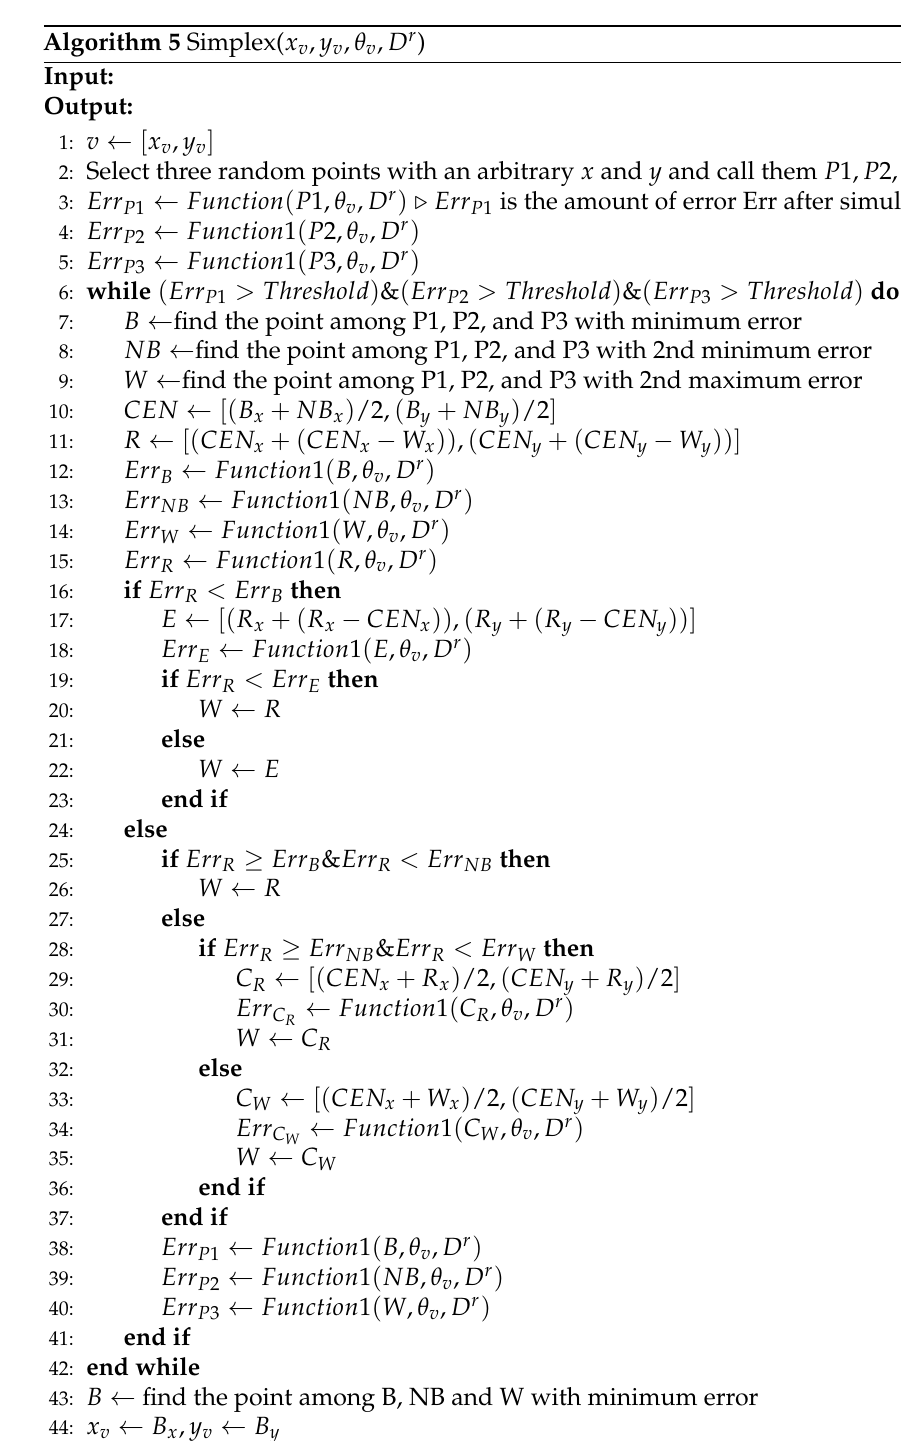
Algorithm 5 Simplex( x v , y v , θ v , D r